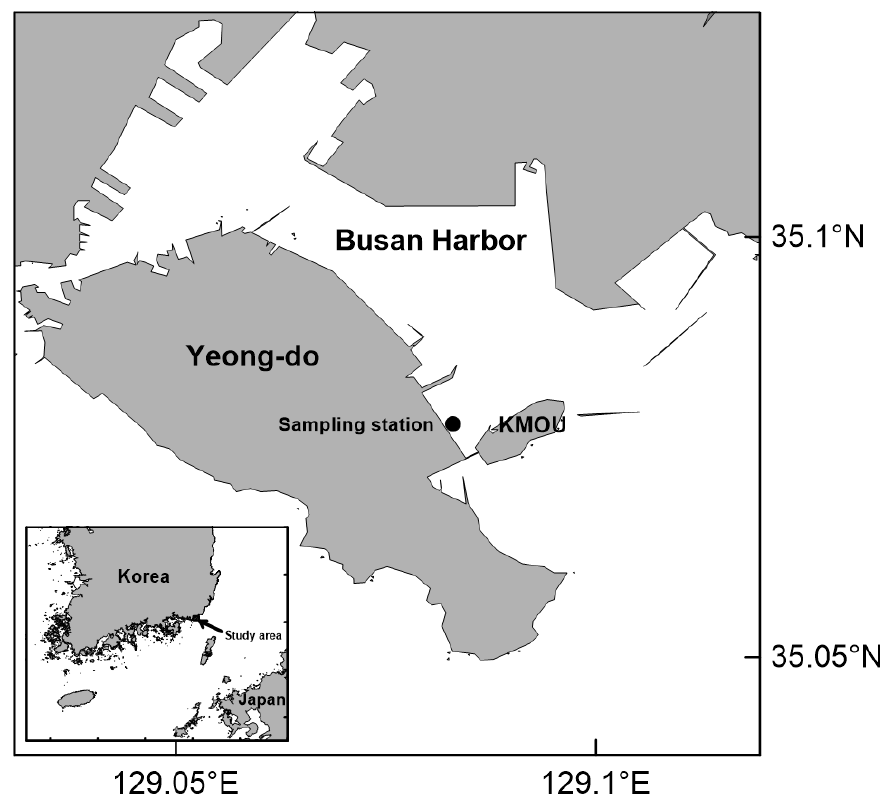
Figure 1. Sampling station in Busan Harbor, Korea. KMOU: Korea Maritime and Ocean Univer- sity.